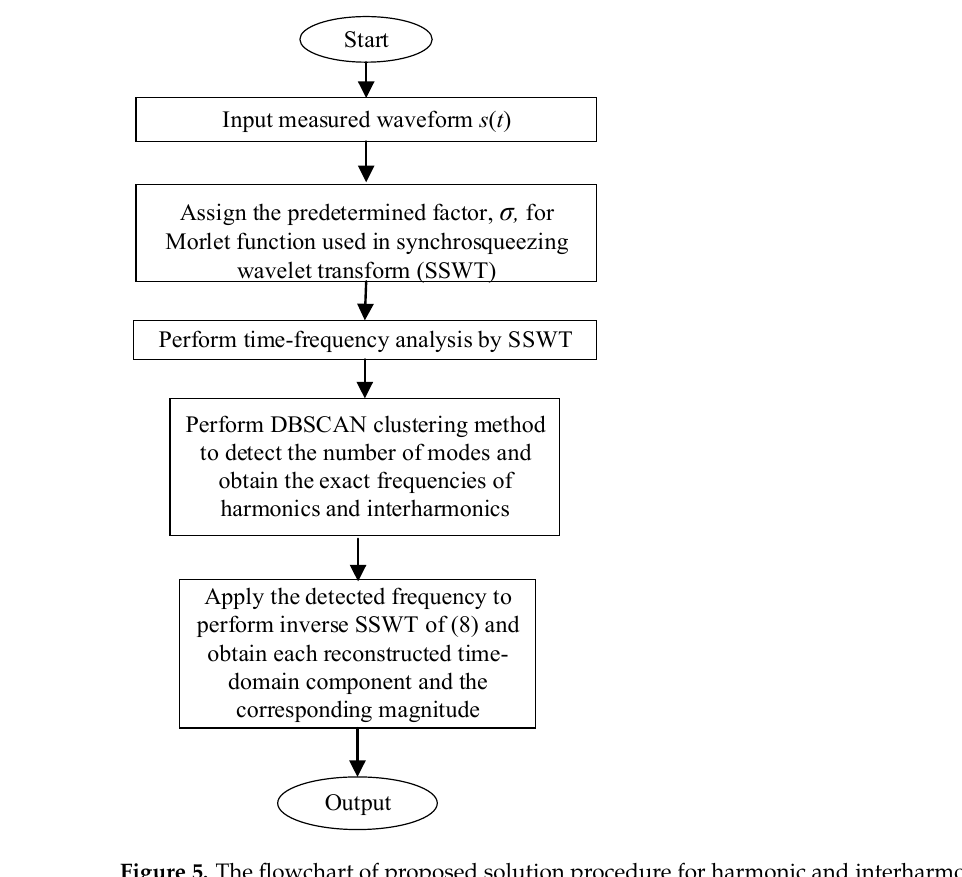
Figure 5. The flowchart of proposed solution procedure for harmonic and interharmonic detec- tion.